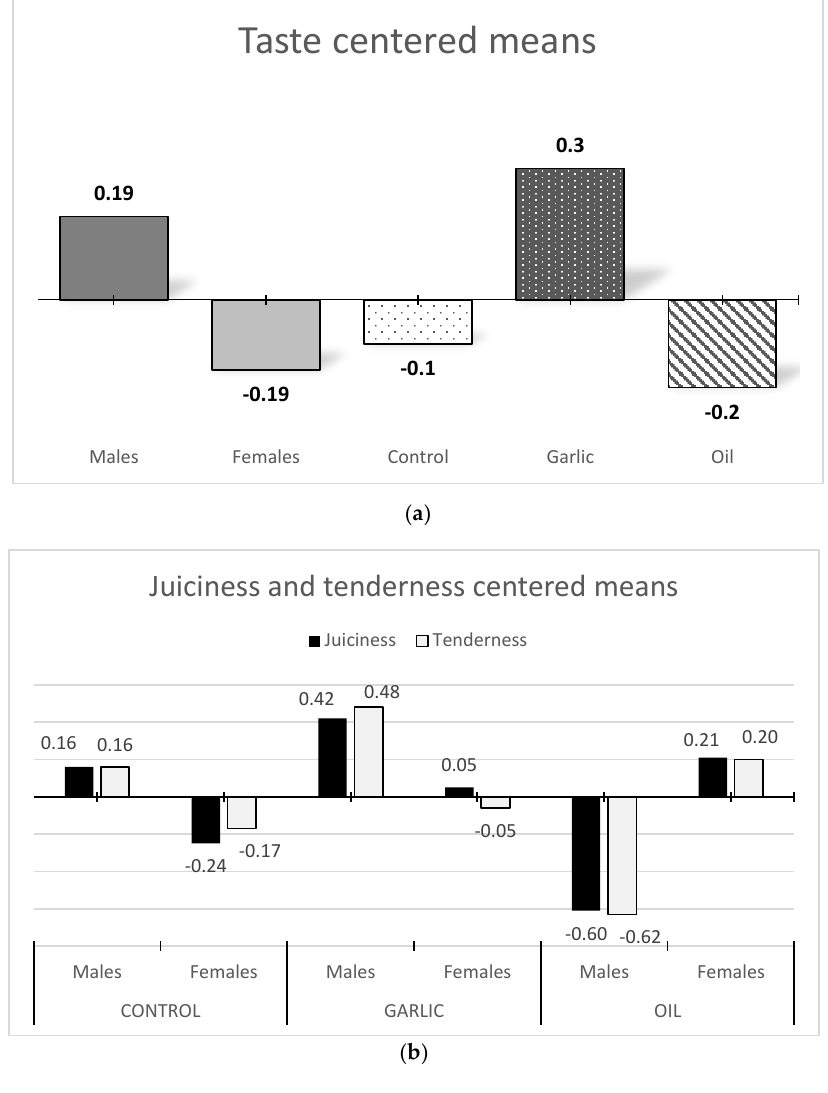
Figure 3. The centered means for sensory variables in a pork-meat consumers home test in function of pig sex and PDE addition. ( a ) centered mens for taste in function of pig-sex or PDE addition. ( b ) centered means for juiciness and tenderness in function of pig sex and PDE addition.